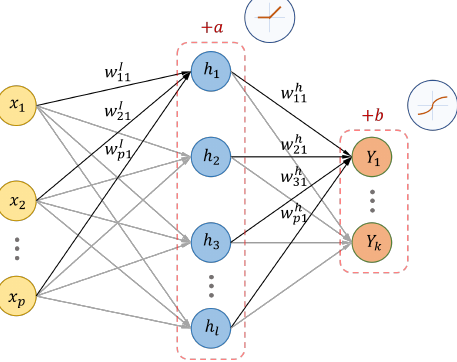
Figure 2. Generic neural